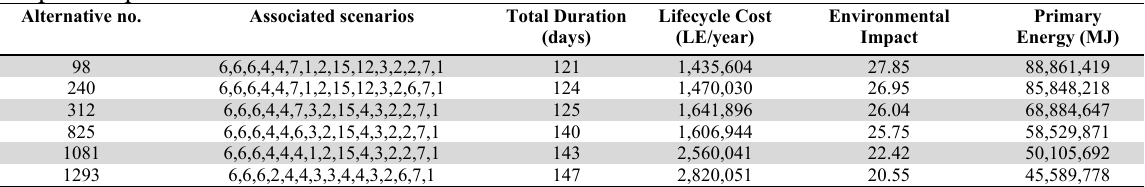
Sample of optimal solutions Alternative